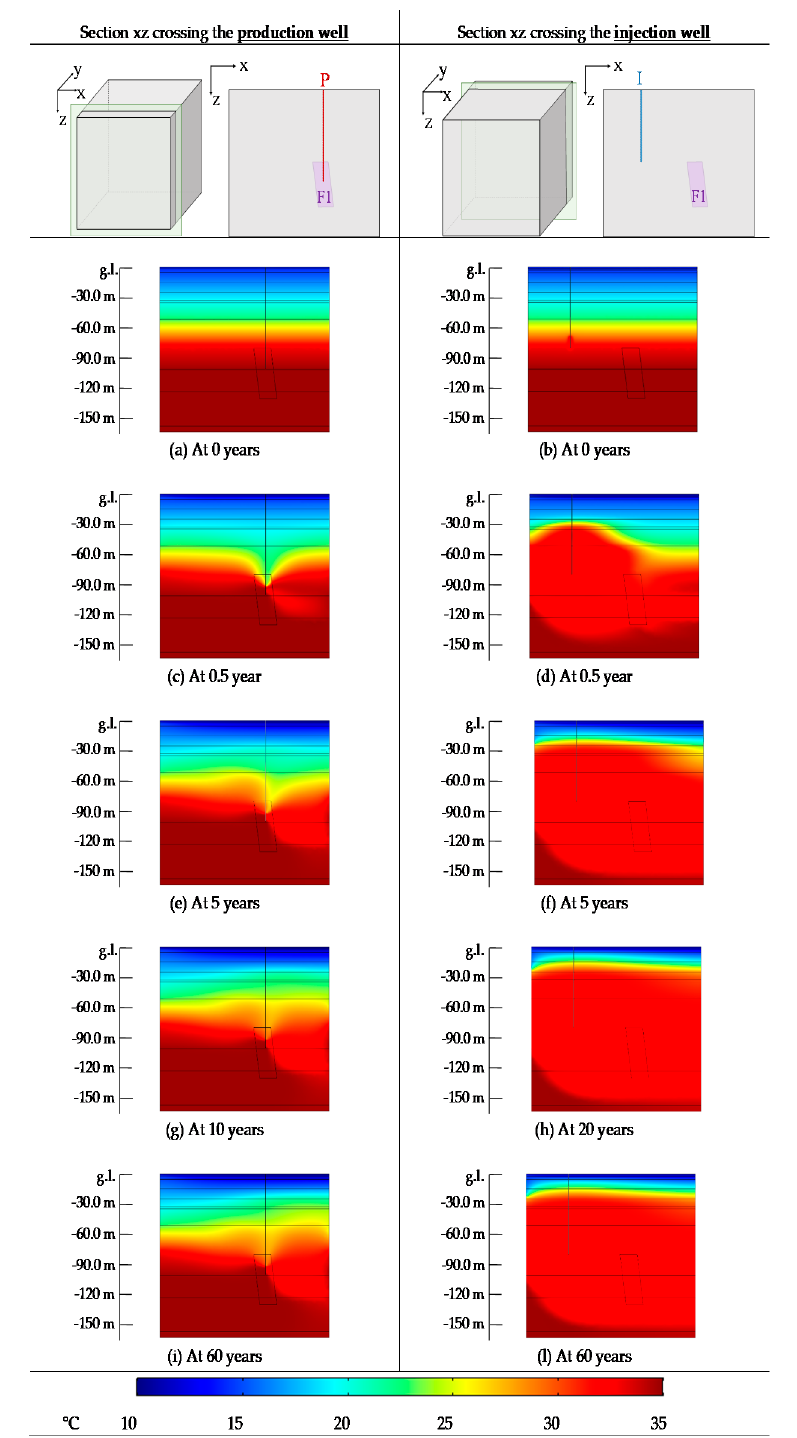
Figure 7. Temperature field of the sections xz crossing the wells, at different times, for Case 1 (single fault).